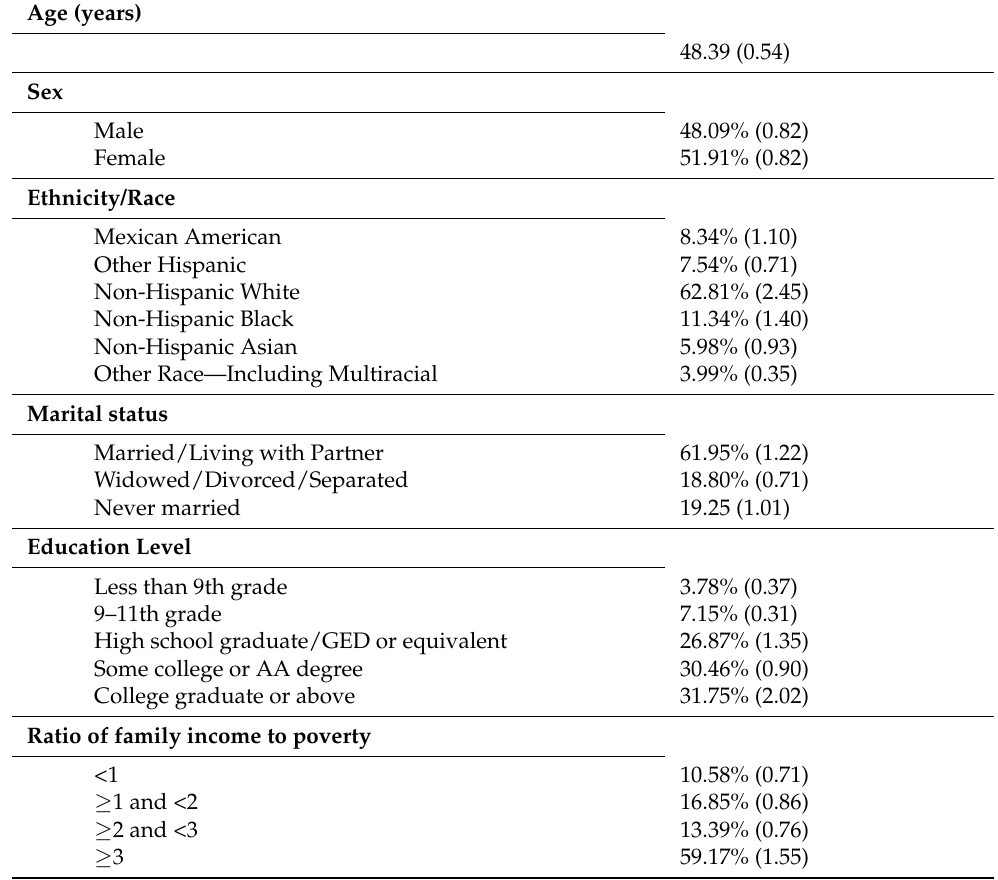
Table 1. Sample characteristics ( n =